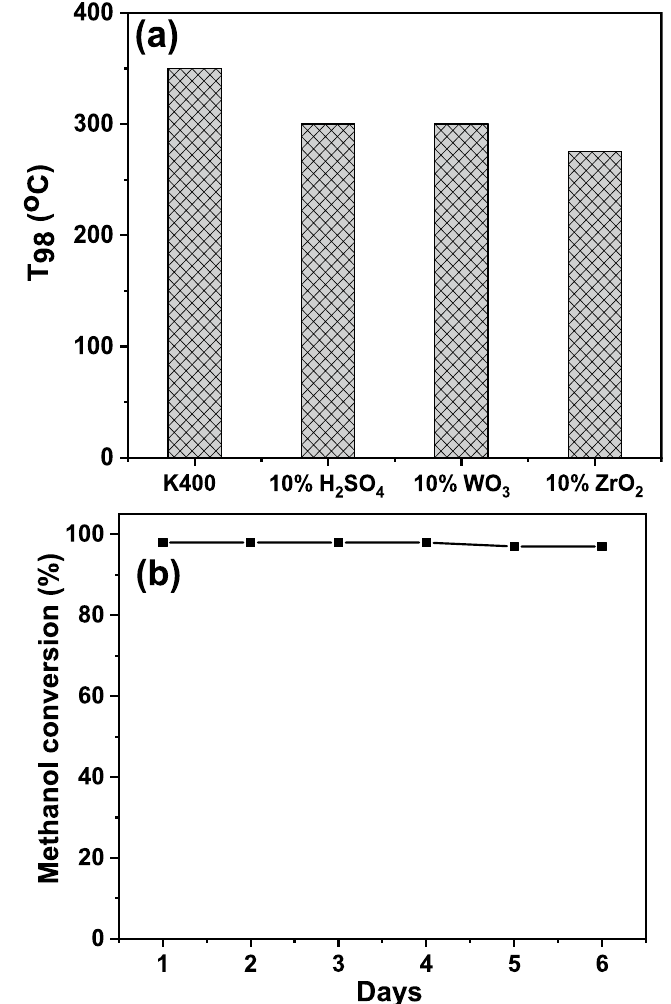
Figure 7. ( a ) T 100 values of K400, 10% H 2 SO 4 /K400, 10% WO 3 /K400, and 10% ZrO 2 /K400 catalysts calcined at 400 °C and, ( b ) long-term stability of 10% ZrO 2 /K400 catalyst calcined at 400 °C at a reaction temperature of 275 °C.